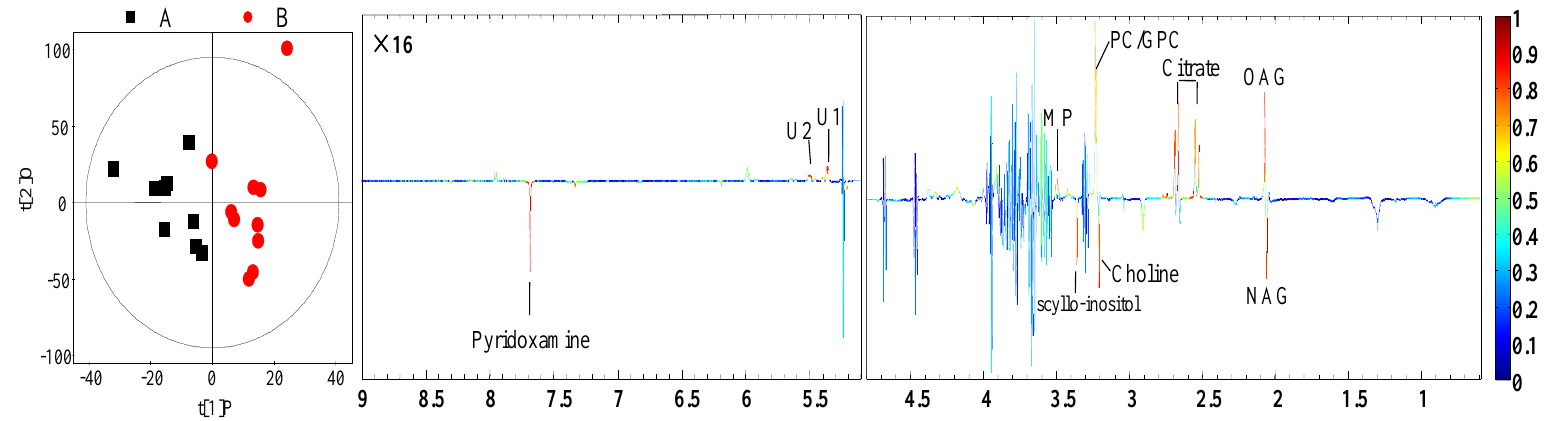
Figure 3. Orthogonal Partial Least Squares Discrimination Analysis (OPLS-DA) scores plots ( left panel ) and the corresponding coefficient loading plots ( right panel ) of milk. A = heat stress treatment; B = thermal neutral treatment.